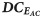
Values of WSSR with a fault in P4 sensor and DCEAC decreased by 3%.